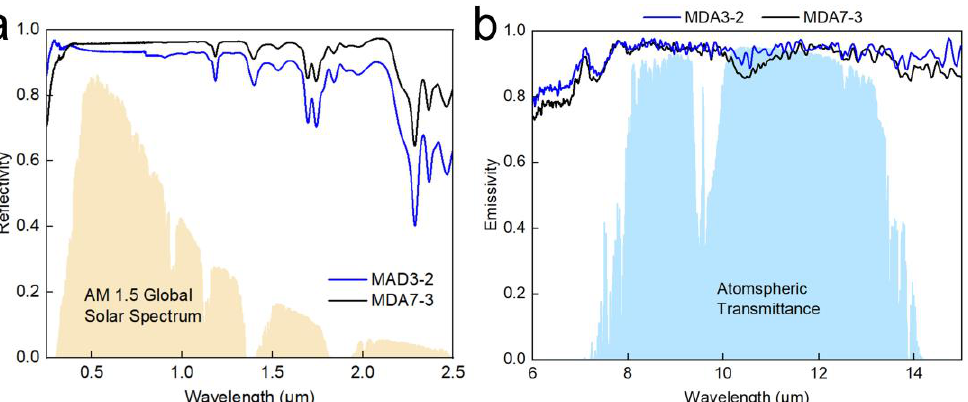
Figure 6. ( a ) Solar reflective spectra of the aerogels. The normalized ASTM G173 global solar spectrum is plotted in the background; ( b ) thermal emissive spectra of the aerogels. Atmospheric transparency windows are plotted as background.